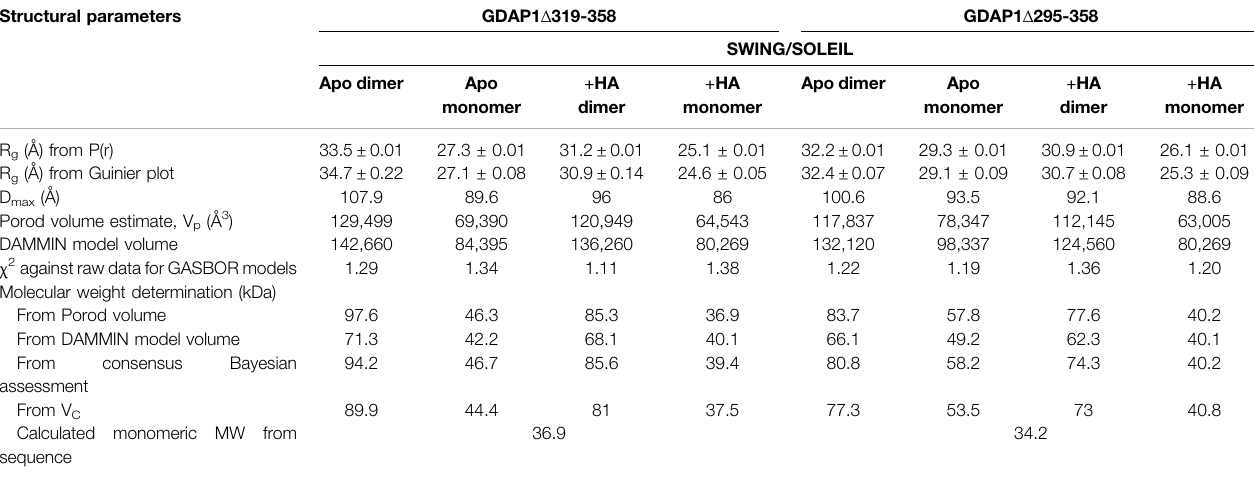
TABLE 4 | SAXS structural parameters of GDAP1 Δ 319-358 and GDAP1 Δ 295-358 in the absence or presence of HA. Structural